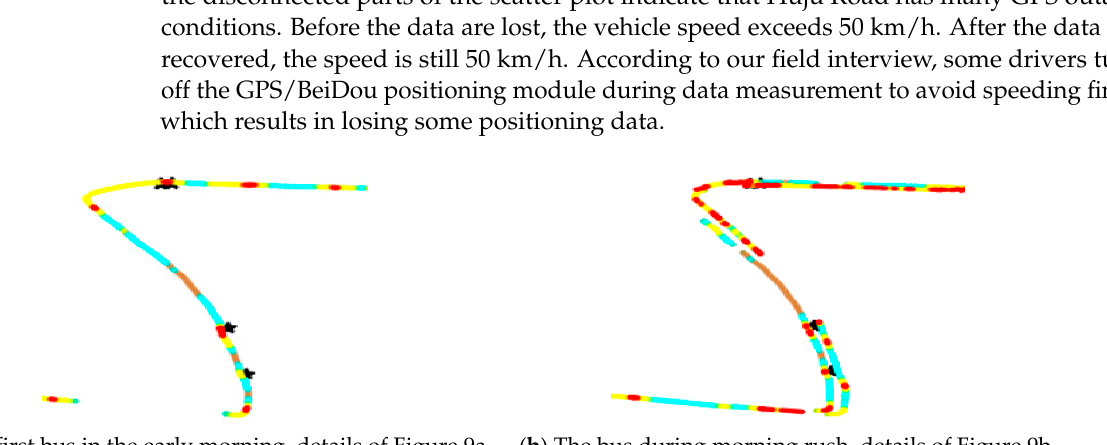
( b ) The bus during morning rush, details of Figure 9b. Figure 10. Detailed heat scatter plot of the vehicle speed in the section on Huju Road, from Figure 9. (2) Emergency brake/stop